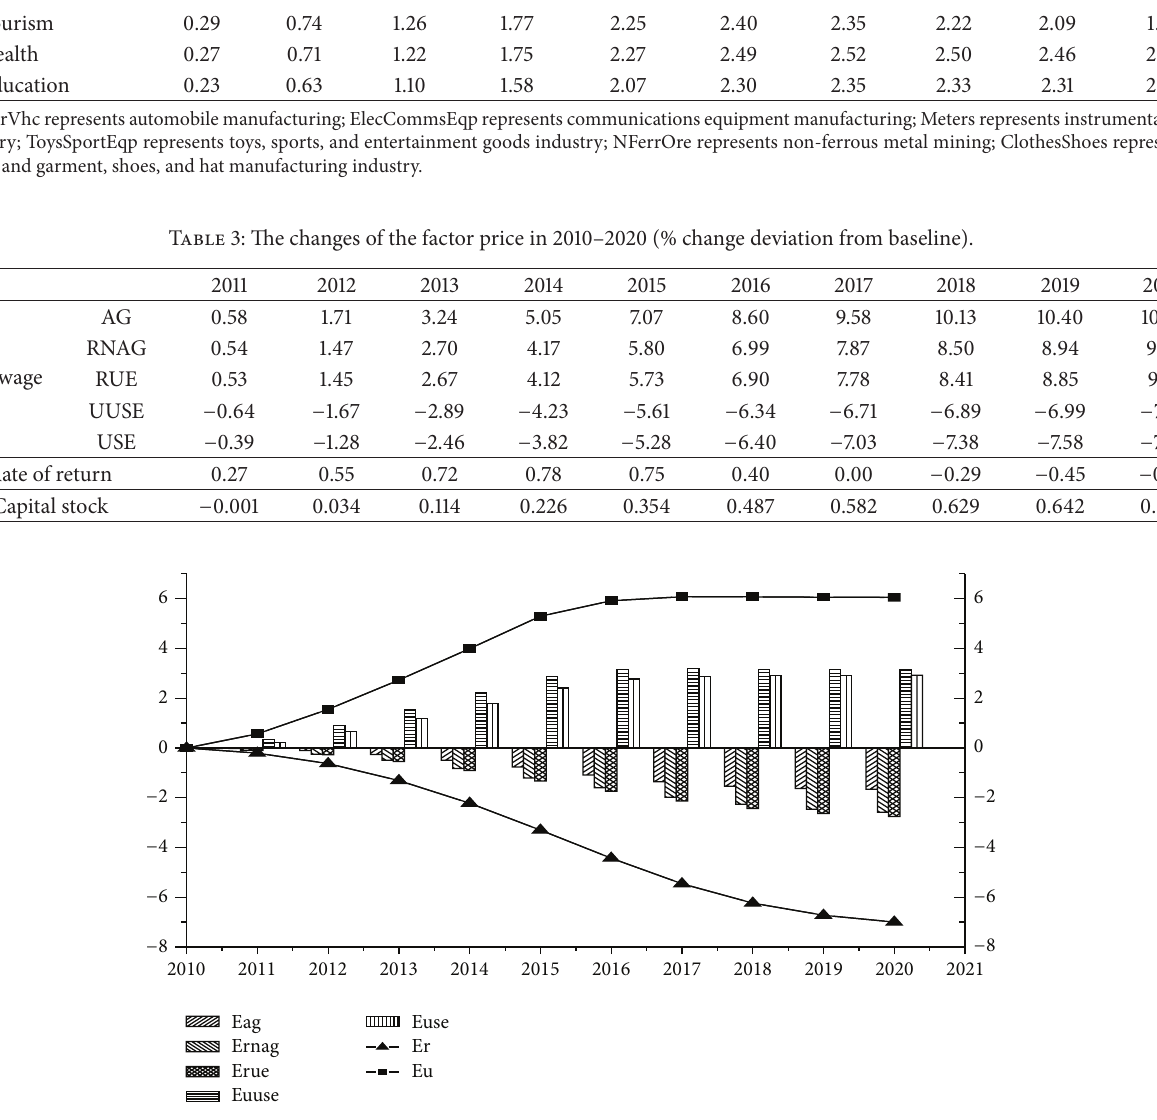
Figure 2: The changes of the labor market structure in 2010–2020 (% change deviation from baseline, 𝐸 is the employment